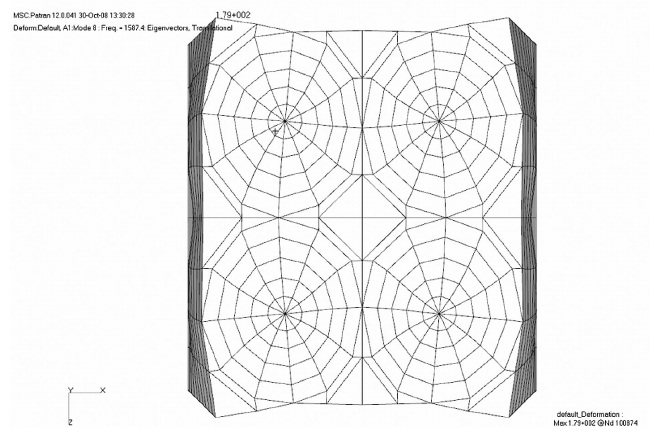
Fig. 21. 8th mode: 1587 Hz.